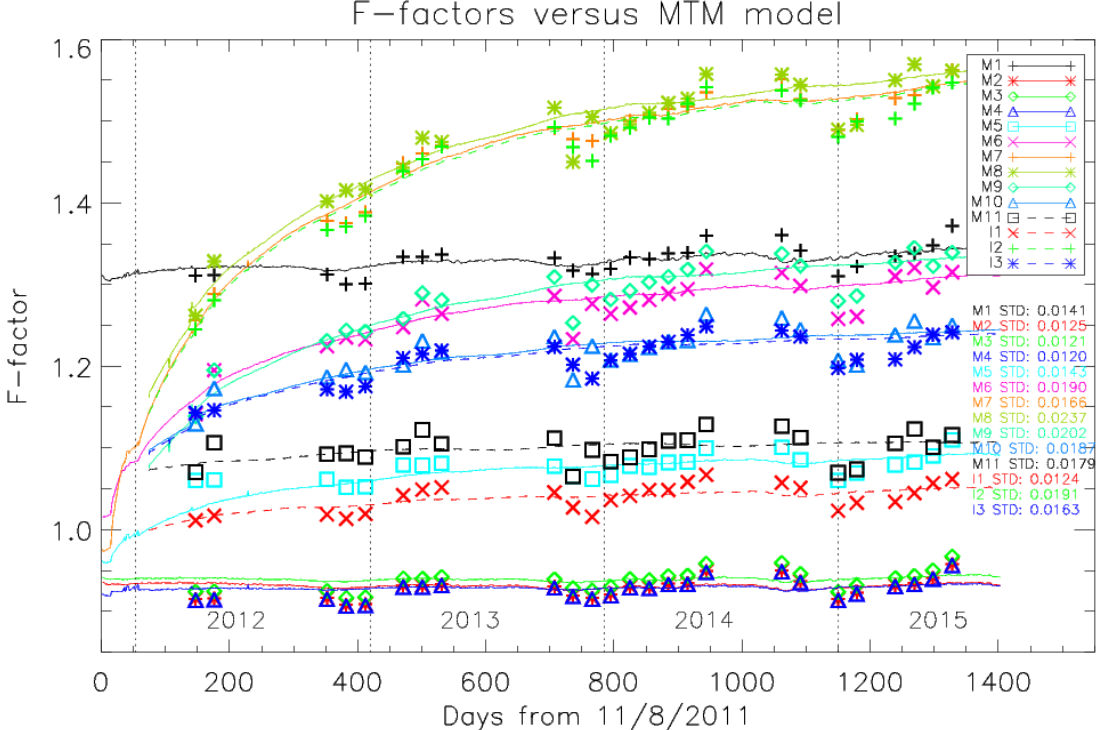
Figure 9. Evolution of VIIRS SD and lunar F-factors for all VIIRS RSBs. The lunar F-factors have been applied with the best fitting scaling factors.